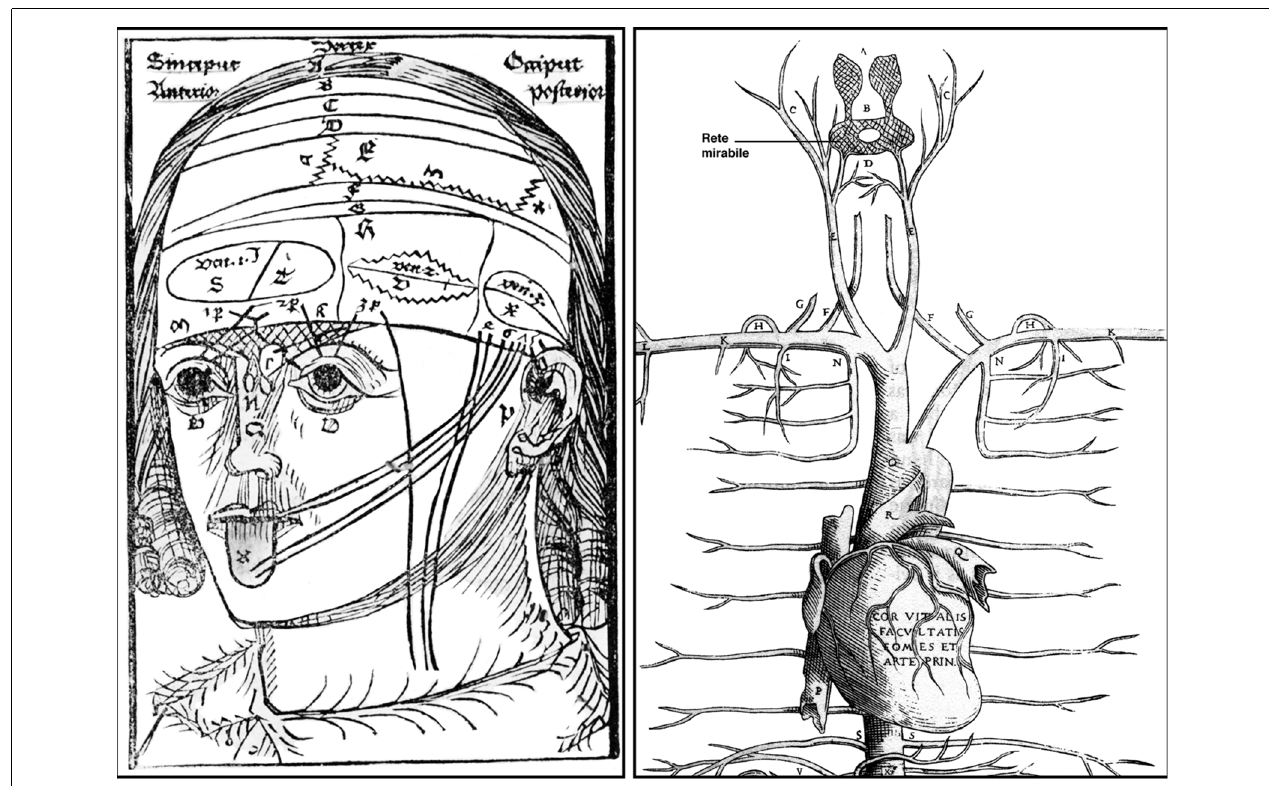
FIGURE 4 | Left: a woodcut from Magnus Hundt’s Anthropologium published in Leipzig in 1501. It offers a crude, schematic view of a human head with layers of the scalp (labeled a, b, c, d), bones, meninges and brain, cranial nerves, ventricles (the three major cells) and the rete mirabile . The latter (shown here for the very first time) is depicted as a roughly triangular crisscrossed structure that extends from the bridge of the nose over both eyes to the lower part of the forehead. Right: detailed of a woodcut from Andreas Vesalius’s Tabulae Anatomicae Sex (Tabula III) published in Venice in 1538. The illustration shows the upper arterial vascularization and includes a clear depiction of the rete mirabile (the name has been added to the original drawing to facilitate its reading). Vesalius’s letter B indicates the rete mirabile proper ( plexus reticularis ), whereas the letter A points to the plexus choriformis , a structure that Vesalius saw as an upper extension of the rete mirabile that plunges within the anterior (lateral) ventricle (Courtesy of the National Library of